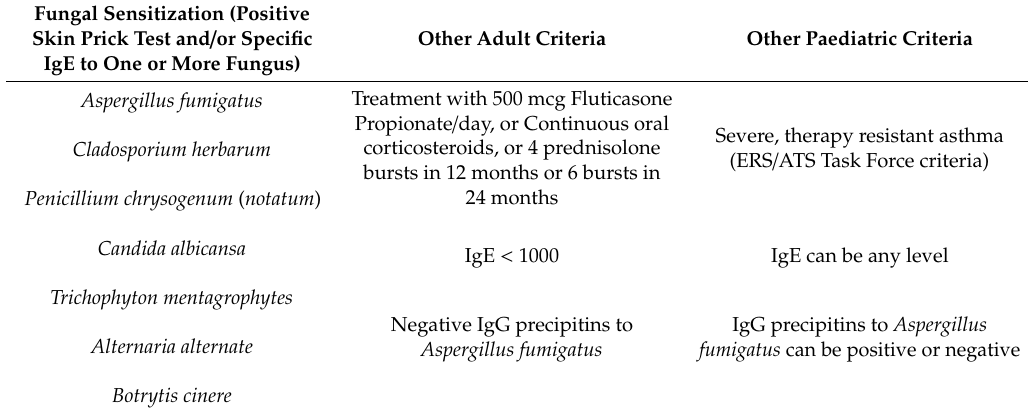
Table 1. Diagnostic criteria for severe asthma with fungal sensitization (SAFS) in adults and children. Fungal Sensitization (Positive Skin Prick Test and / or